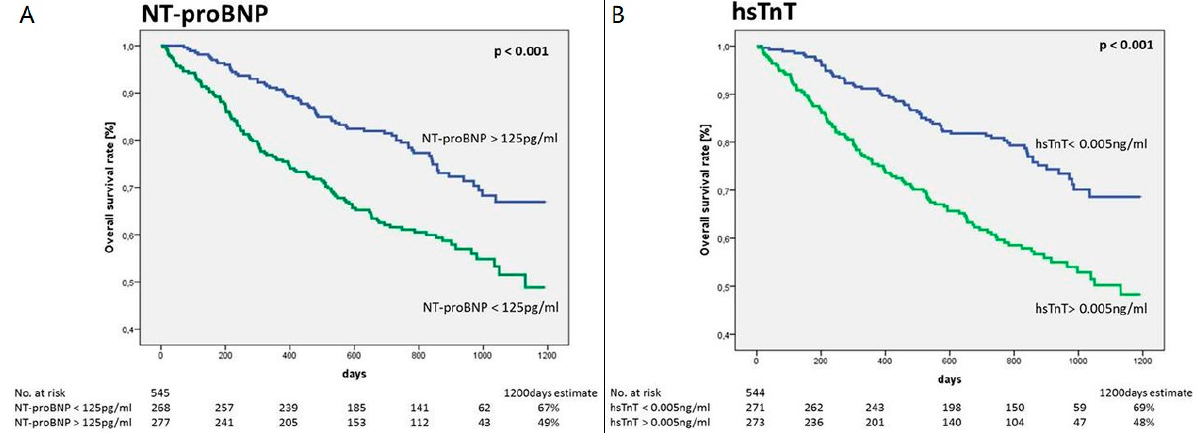
Figure 9. Prognostic value (Kaplan–Meier estimates) for all-cause mortality of ( A ) N-terminal pro B-type natriuretic peptide (NT-proBNP) with a threshold of 125 pg/mL and ( B ) hsTnT with a threshold of 0.005 ng/mL for patients with newly diagnosed tumour disease ( p < 0.001 between two groups for NT-proBNP and hsTnT, log-rank test). Modified from Pavo et al. [82].